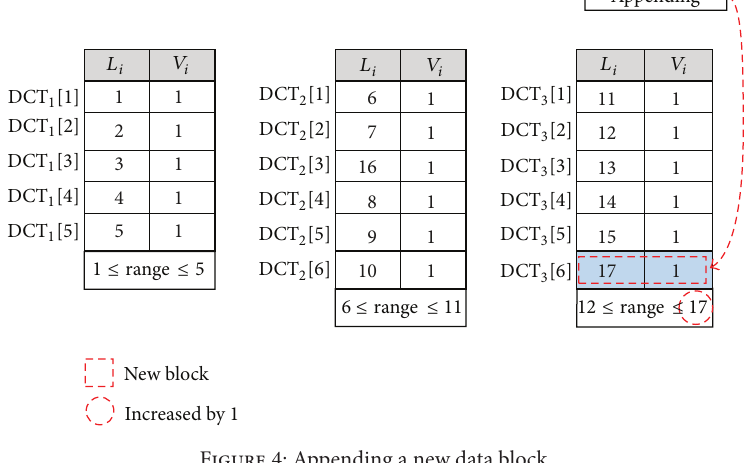
Figure 4: Appending a new data block.